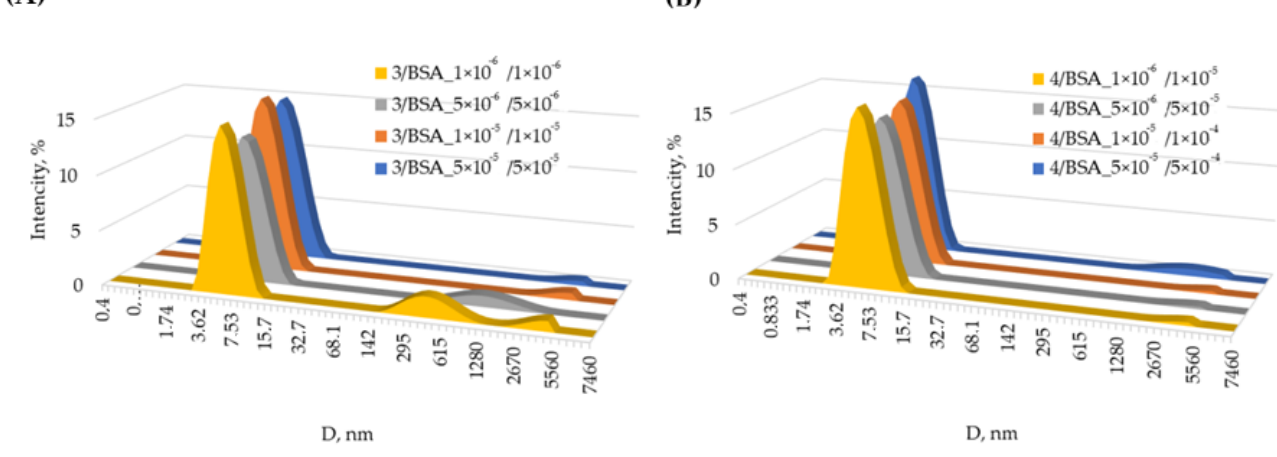
Figure 2. DLS profiles of solutions of BSA in the presence of the 3 ( A ) and 4 ( B ).